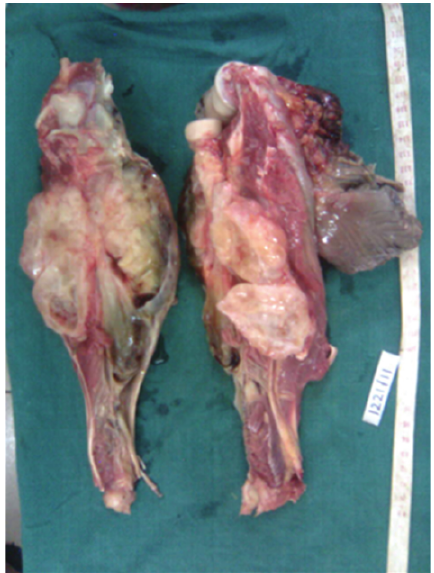
Figure 1: Cut section of the specimen showing a grey white myxoid tumour located intramuscularly between radius and ulna.